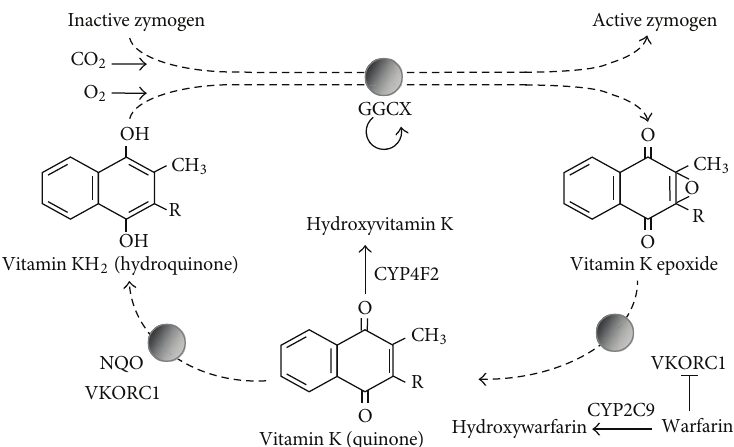
F 2: Vitamin K cycle and warfarin metabolism. Inactive zymogens, among which are the VK-dependent coagulation factors II, VII, IX, and X, are activated by gamma-carboxylation by the gamma-glutamyl carboxylase (GGCX). e cofactor for this carboxylation step is VK, which is transformed into VK epoxide. is epoxide is then reduced by the VK-epoxide reductase of VKORC1 to quinone. Warfarin speci�cally blocks the initial reduction step, while CYP4F2 catalyzes the formation of hydroxyvitamin K out of quinone.